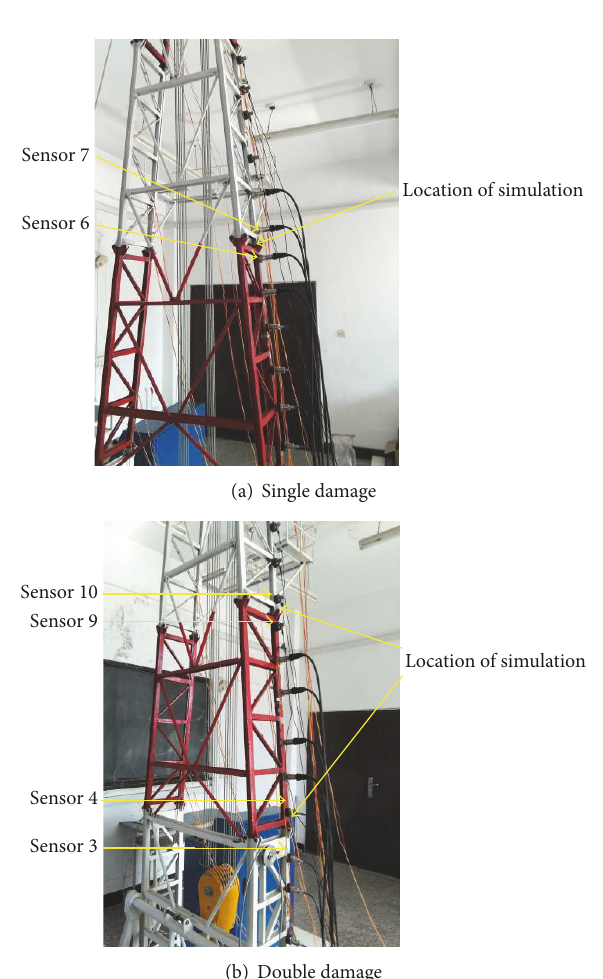
Figure 8: Damage location simulation and sensor